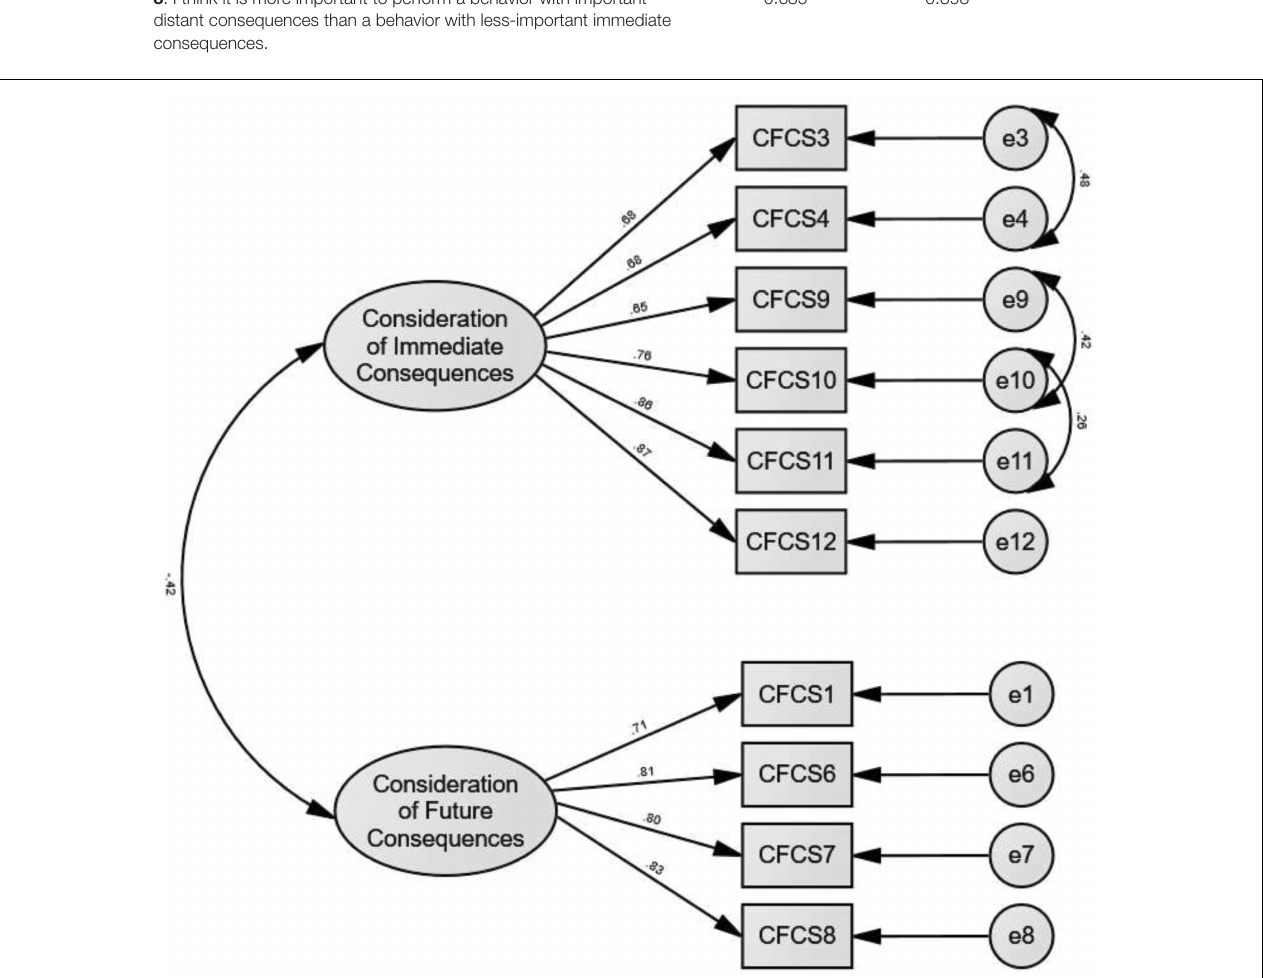
FIGURE 1 | The final measurement model of CFC scale among Malaysian young